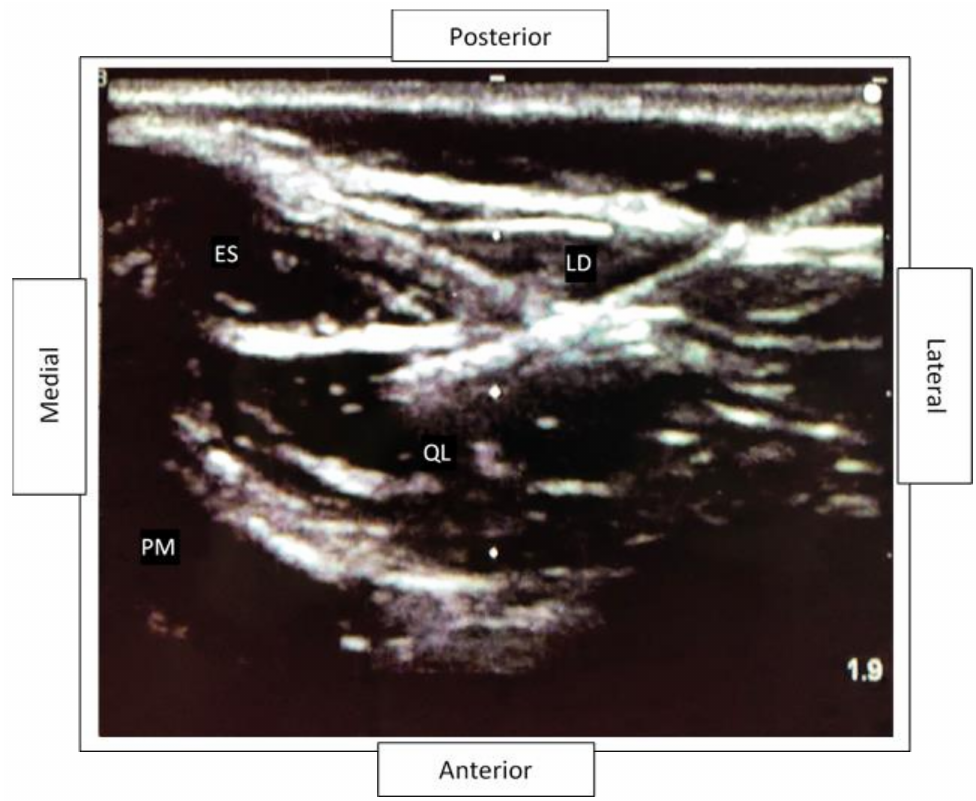
Figure 1. Ultrasound of block administration plan; QL—quadratus lumborum. LD—latissimus dorsi. ES—erector spinae. PM—psoas